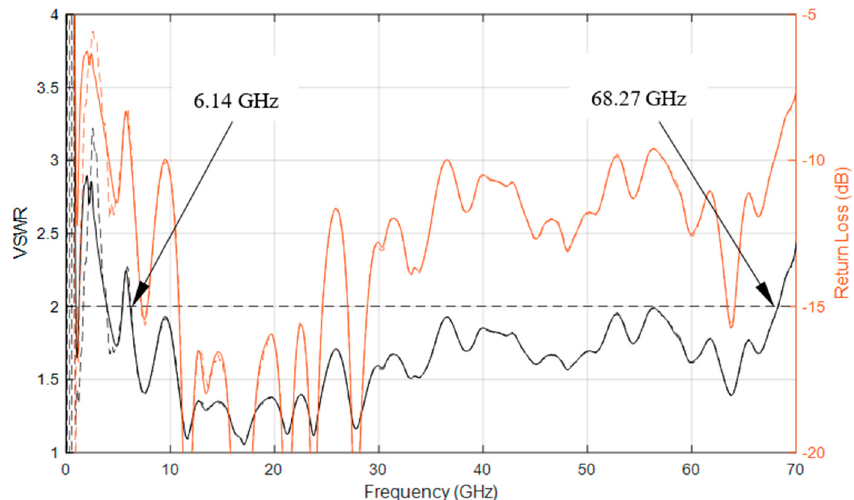
Figure 7. The input characteristics of the base MBA shown in Figures 4 and 6, and solid and dashed lines are obtained from our FD-TD solver and GEMS, respectively.